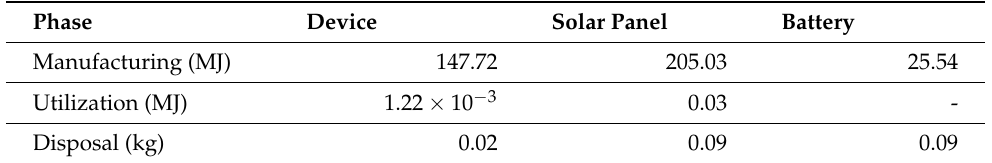
Table 3. Impact of energy and waste of one IoT device with energy harvesting in the three phases of the